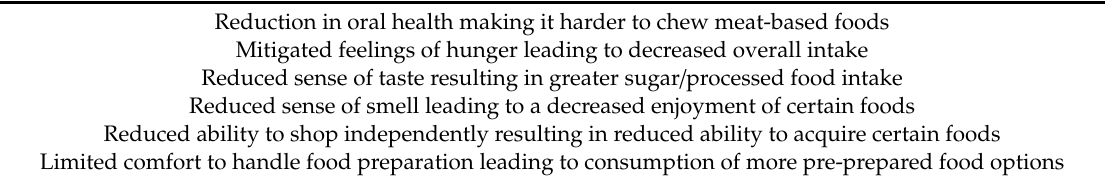
Table 1. Reasons for diminished protein intake in older